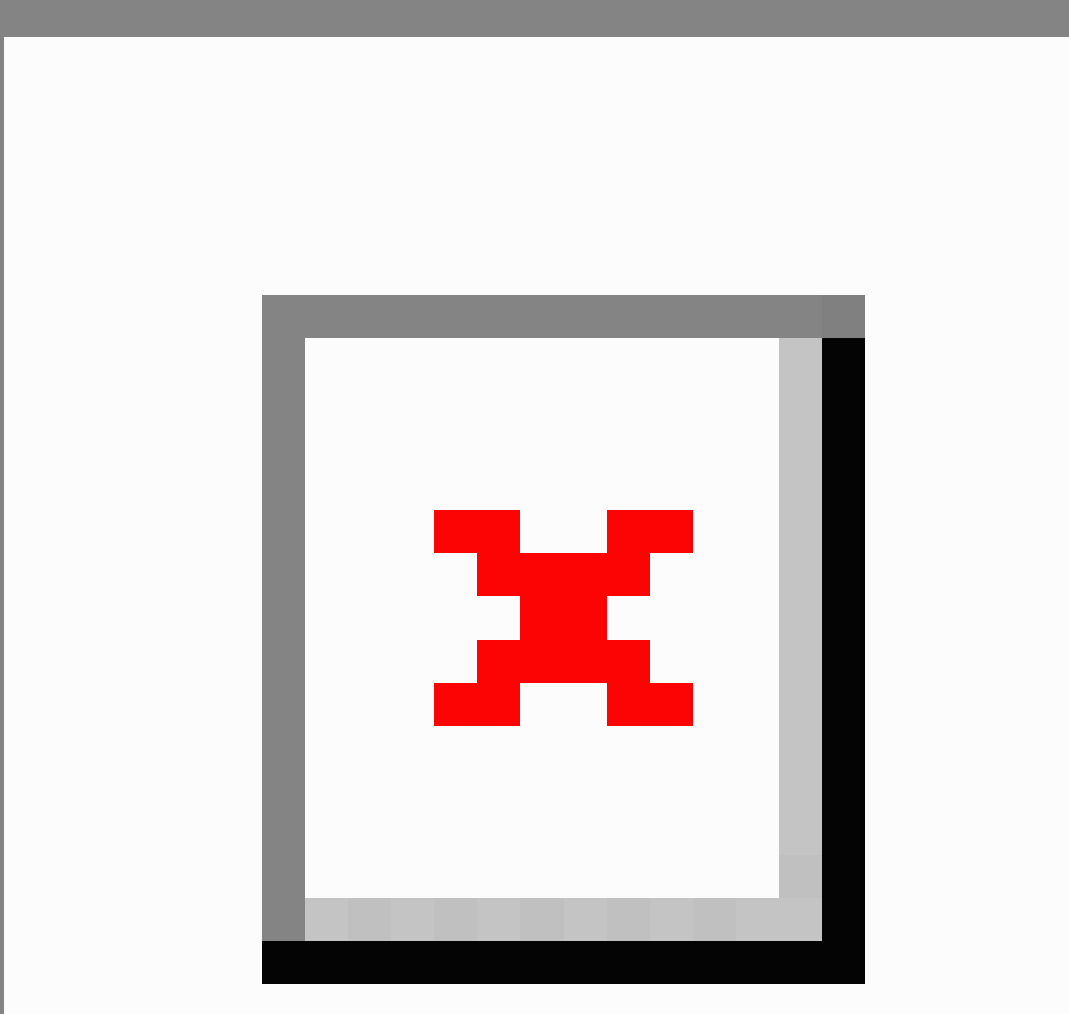
Figure 3. Survey data for patient satisfaction with overall prenatal care between Babyscripts (Brx) and control groups. For each time point, Brx and control patients are given a survey. The total numeric scores for all questions at that time point is calculated. All numeric scores are then normalized to 1 to standardize between different numbers of survey questions. SOC: standard of